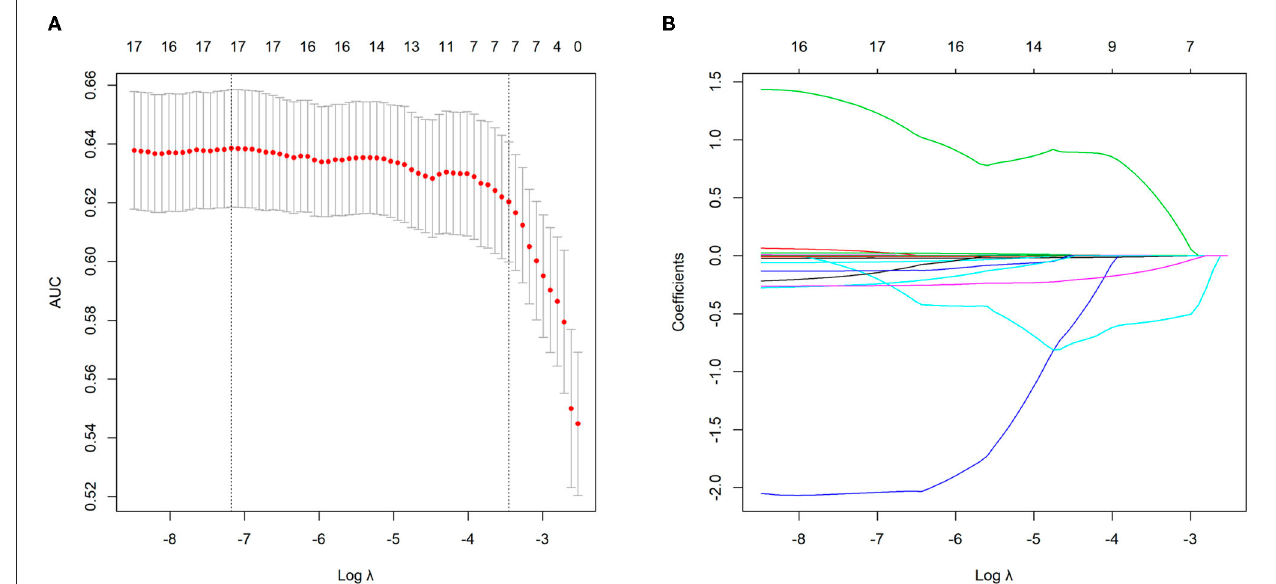
FIGURE 1 | Continuous variables selection using the least absolute shrinkage and selection operator (LASSO) logistic regression model in the training group. (A) The area under the curve (AUC) was plotted vs. log (Lambda). Dotted vertical lines indicate the lambda value with the minimum error and the 1 standard error of the minimum criteria. (B) LASSO coefficient profiles of the continuous